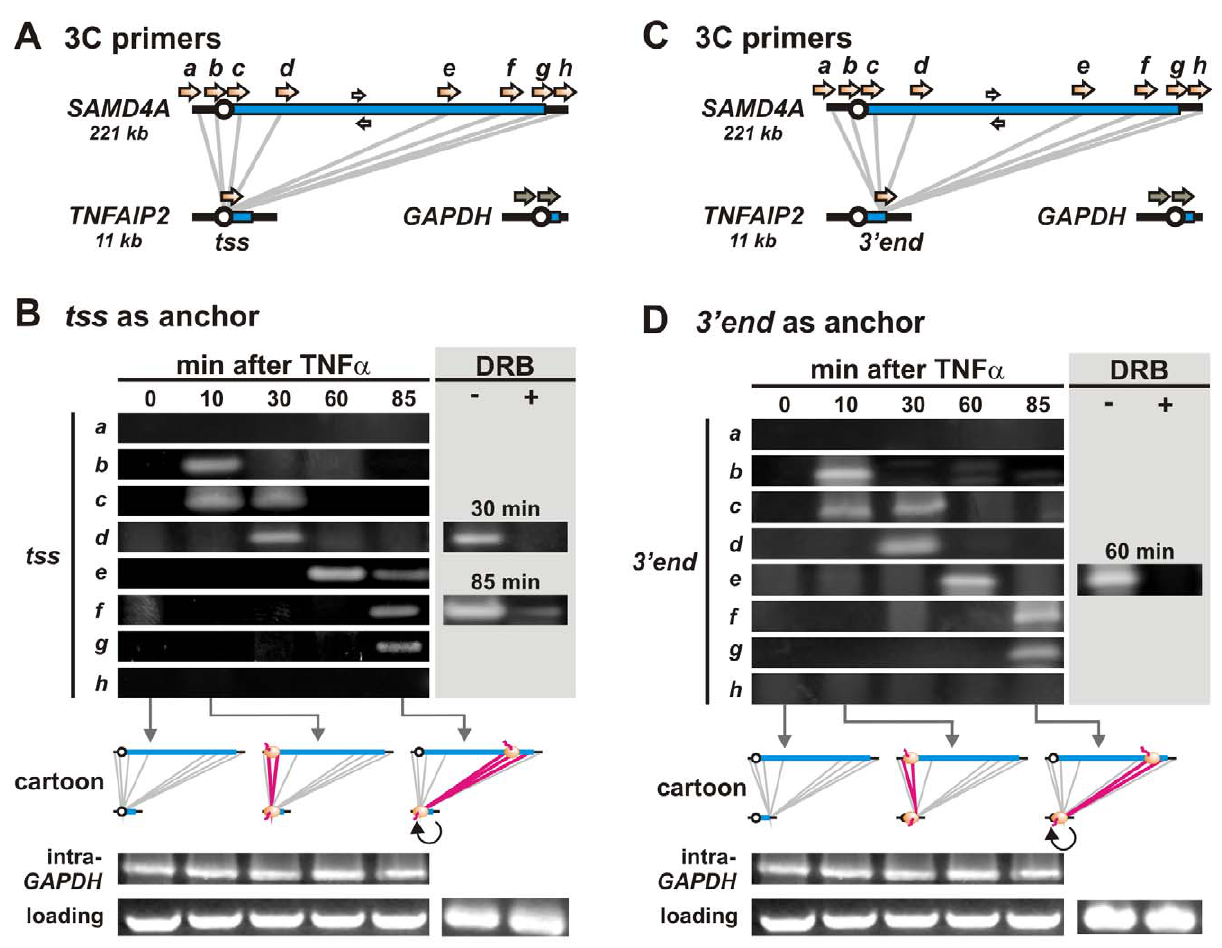
Figure 3. Contacts between two TNF a -responsive genes 50 Mbp apart on the same chromosome follow engaged polymerases. (A) Positions of 3C primers on SAMD4A and the tss of TNFAIP2 (orange arrows) and GAPDH (grey arrows). Grey lines: 3C interactions monitored. White arrows: primers used for loading controls. (B) 3C. HUVECs were treated with TNF a for 0–85 min, 3C templates prepared using Sac I, and PCR conducted using equal weights of DNA and the primer pairs indicated; after gel electrophoresis and SYBR green staining, images of resulting gels are shown. The presence of a band reflects a high contact frequency between respective primer targets. Cartoons illustrate where polymerases are bound at different times and the interactions analyzed (grey lines); red lines indicate interactions yielding bands, and these always correlate with the presence of a polymerase on both contacting partners. In selected cases, DRB was added 20 min prior to harvesting cells (grey box); this reduces band intensity, indicating that contacts depend on transcription. GAPDH primers yield uniform levels of amplimers, as do loading controls. (C) Positions of 3C primers on SAMD4A and the 3 9 end of TNFAIP2 . (D) Changing contacts between SAMD4A and the 3 9 end of TNFAIP2 . The pattern is essentially the same as that in panel (B). Panels (B) and (D) share the same pair of loading and intra- GAPDH controls (excluding 6 DRB), so the same image is shown in both panels.